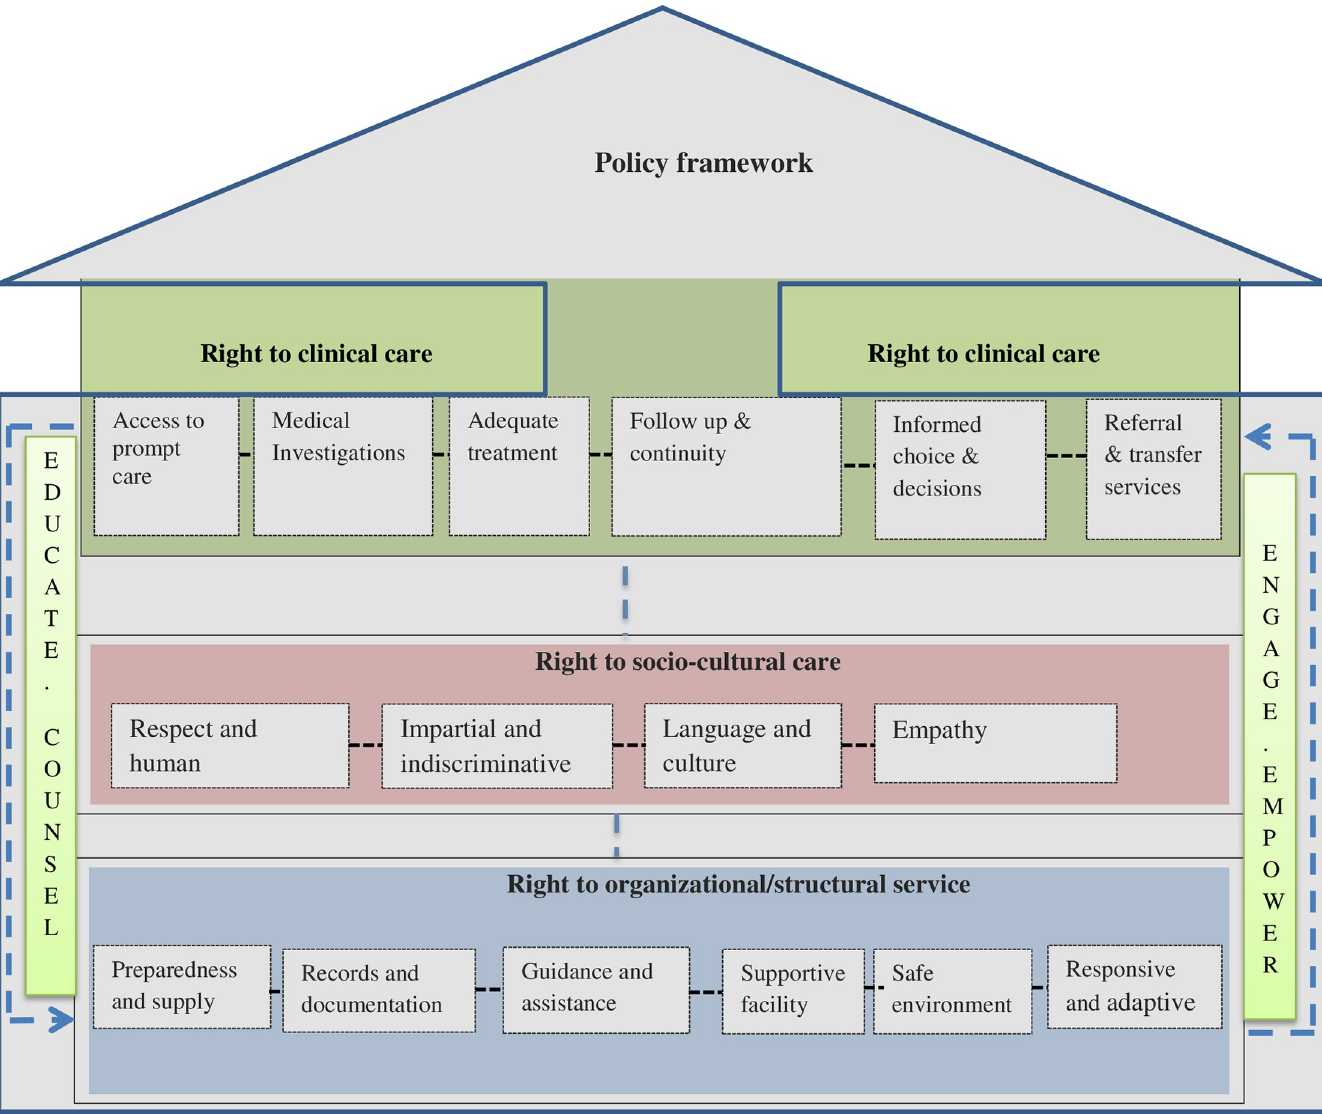
Fig 1. An emergent framework of perceived patients’ rights in the healthcare process in the study contexts, Oromia, Ethiopia, June 2019. As emerged from data through inductive analysis, there were three major dimensions of patients’ perceived rights to adequate healthcare which included organizational or structural dimension, socio-cultural aspect of care, and clinical care. Each dimension consisted of more specific rights conceptualized and presented according to hypothesized relationships to each other that suggest the potential pathways to enhance patients’ rights in the healthcare delivery process. In this conceptualized framework, education, counseling, engaging, and empowering patients were emerged as cross-cutting and supportive to the fulfillment of other components of patient’s rights. Additionally, devising a policy framework on the patient’s right to healthcare provides an institutionalized platform to protect patients’ rights. The details of the major perceived healthcare rights with sub-categories were described